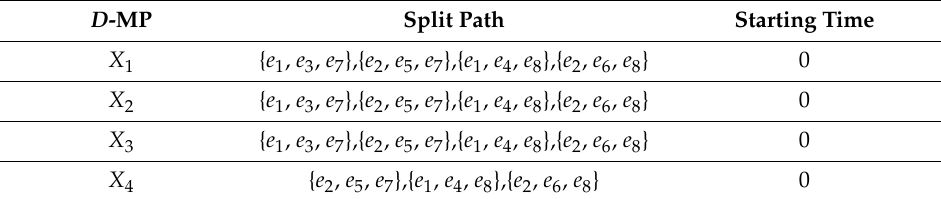
Table 22. The test results of Step